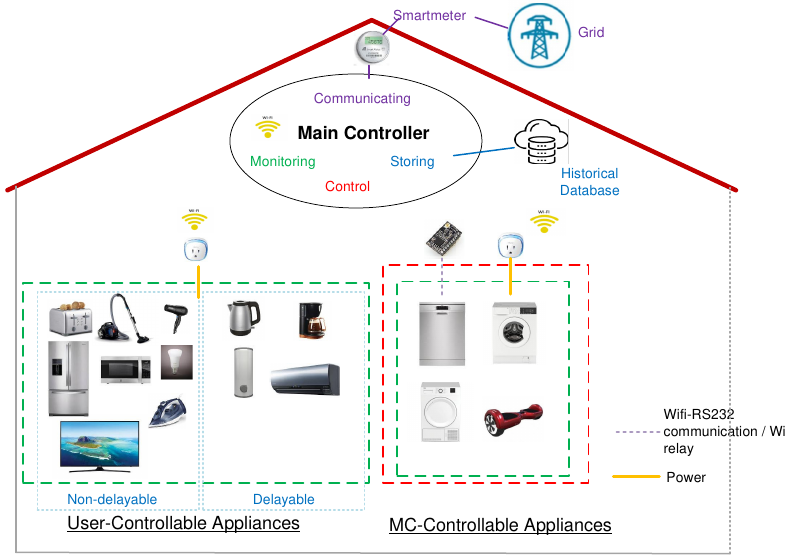
Figure 1. AS-REMS